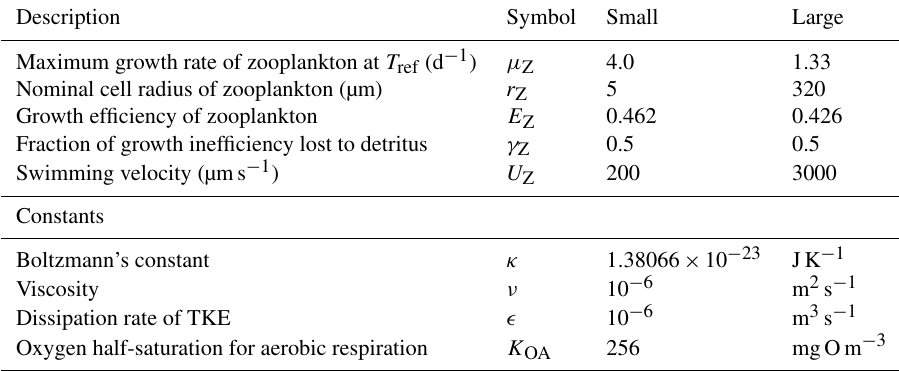
Table 12. Constants and parameter values used for zooplankton grazing. Dissipation rate of turbulent kinetic energy (TKE) is considered constant.